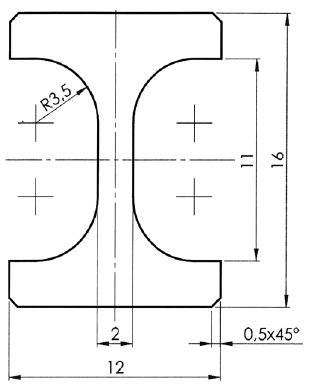
FIG. 12. Tensile specimen dimensions.